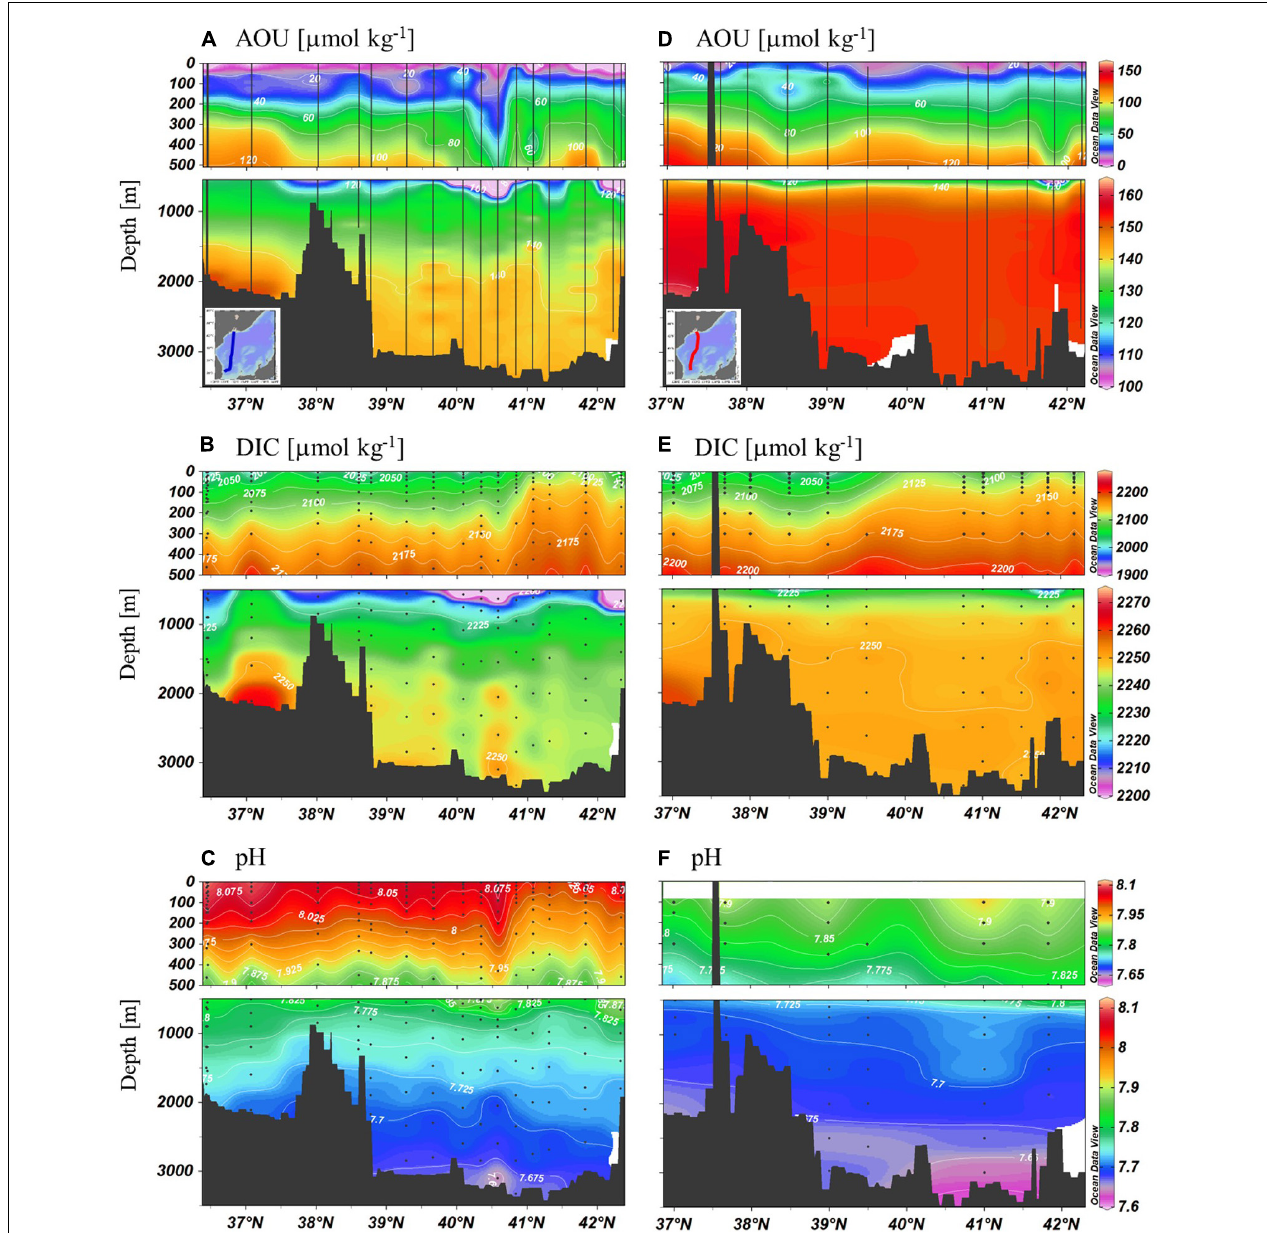
FIGURE 4 | Meridional sections of AOU, DIC, and pH approximately along a north–south transect observed in 1999 (A–C) and in 2019 (D–F) . Note the scale difference for the upper layer and the bottom layer. Blank area in panel (F) means no data.